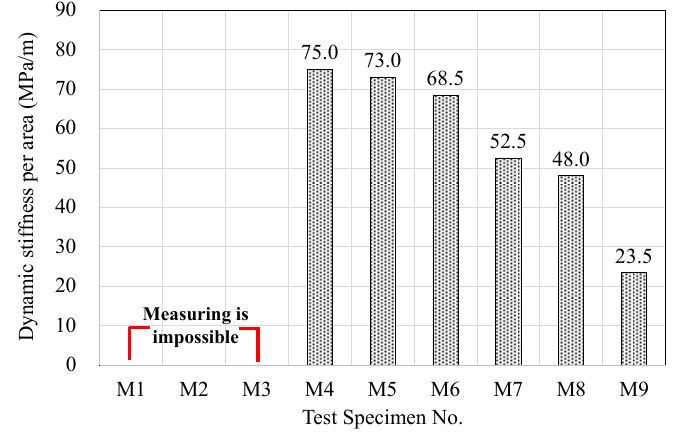
Figure 9. Variations of dynamic stiffness according to mixing conditions.